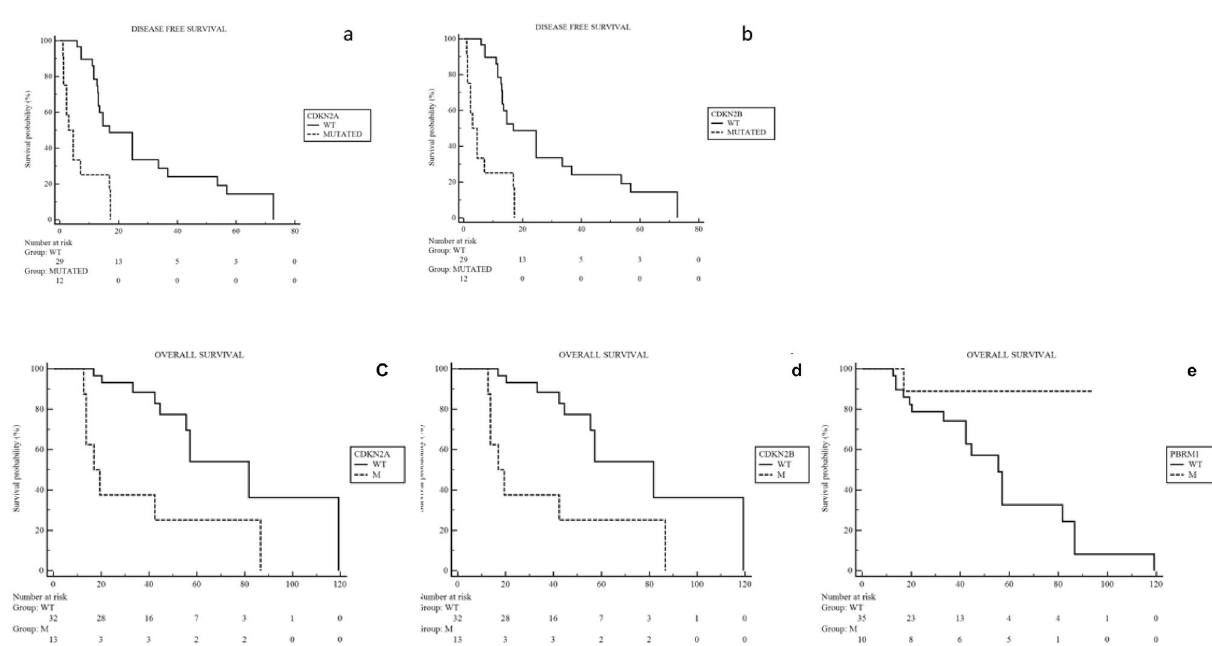
Figure 3. Kaplan Meyer curves of DFS and OS from surgery according to the altered genes with prognostic